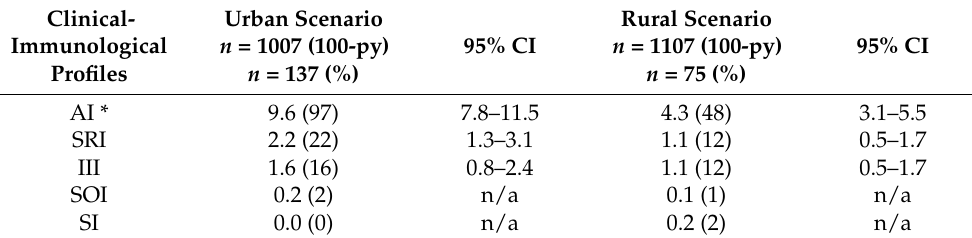
Table 2. Incidence of the clinical-immunological profiles of human L. ( L. ) infantum chagasi -infections in distinct urban and rural epidemiological scenarios in Par á State, in the Brazilian Amazon.